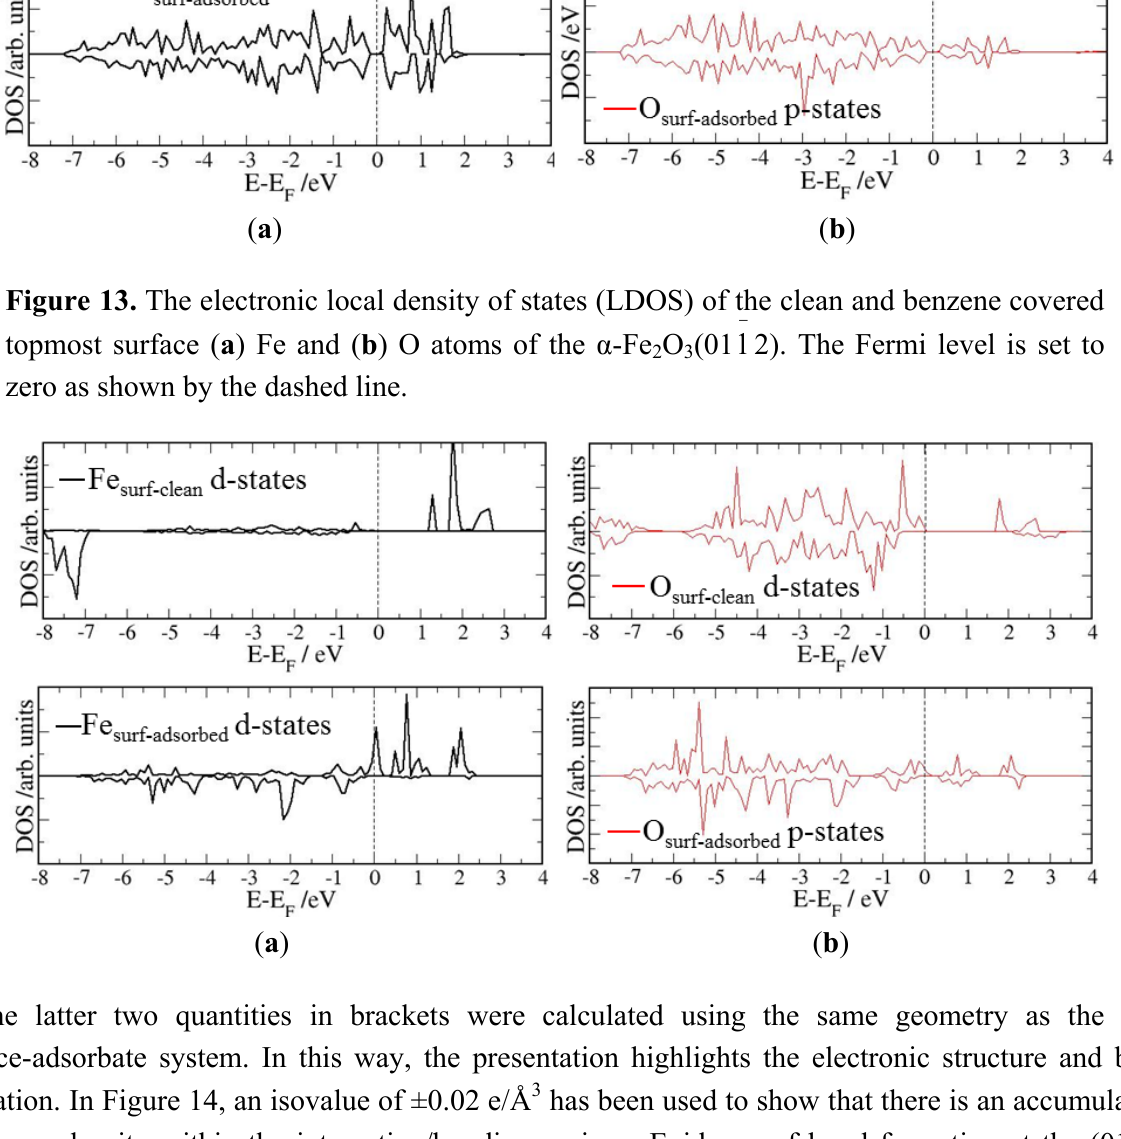
Figure 12. The electronic local density of states (LDOS) of the clean and benzene covered topmost surface ( a ) Fe and ( b ) O atoms of the α-Fe zero as shown by the dashed line.